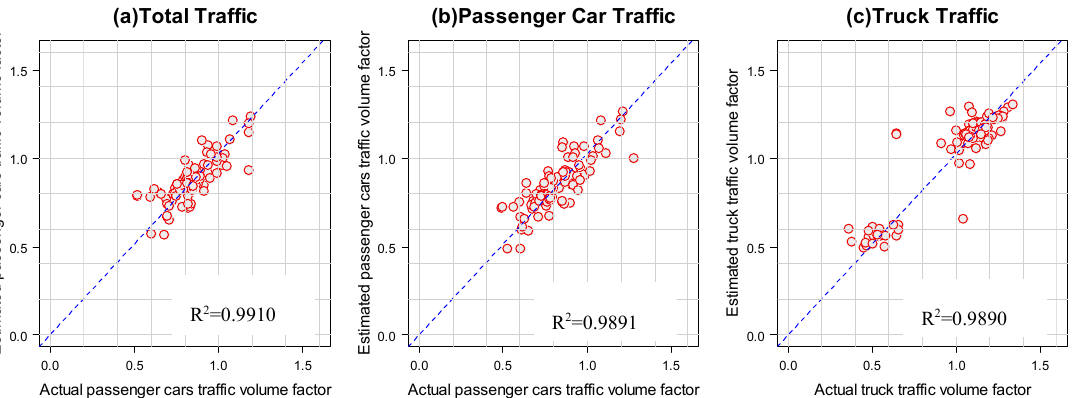
Figure 14. The accuracy of temporal transferability for dummy variable regression model at Red Deer Highway 2.